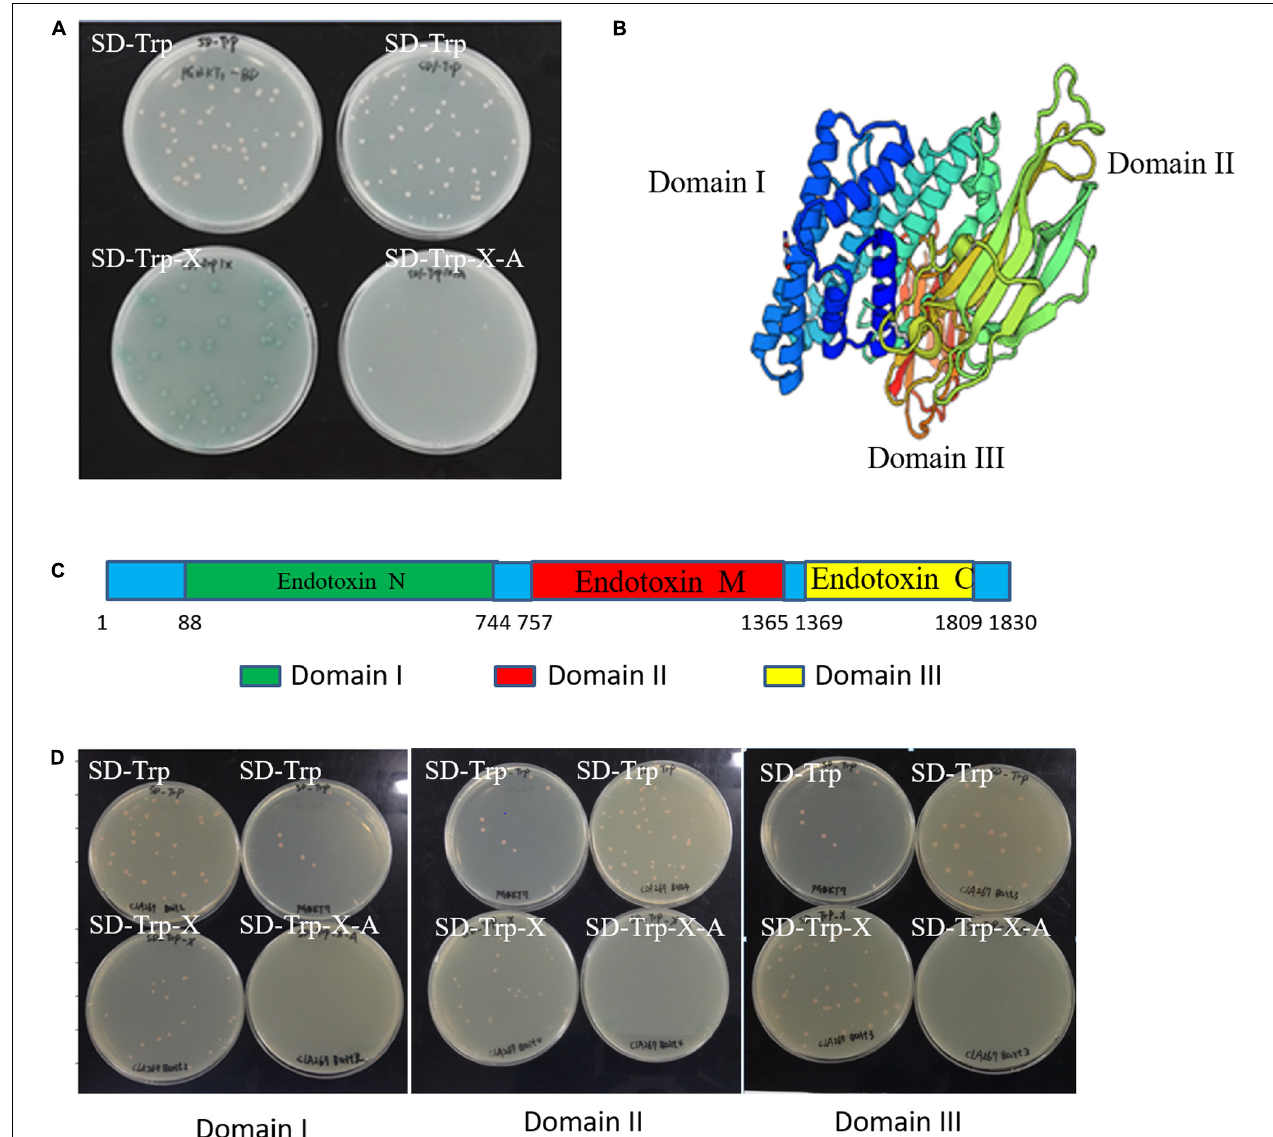
FIGURE 1 | Self-activation and cytotoxicity detection in the Cry1Ab/c bait yeast strain. (A) The growth of full-length Cry1Ab/c-BD yeast colonies on nutrient-deficient SD/-Trp, SD/-Trp/X medium supplemented with x-alpha-gal (X) and SD/-Trp/X/A medium harboring strong abaR inhibitors; (B) A three-dimensional model of the full-length Cry1Ab/c foreign protein was predicted using Swiss-model online software (Adang and Crickmore, 2014); (C) A schematic diagram of the nucleic acid sequence sites for initiation and termination which were cut into three domains; (D) The growth of bait Domain I-BD, Domain II-BD and Domain III-BD yeast colonies on nutrient-deficient SD/-Trp, SD/-Trp/X, and SD/-Trp/X/A,